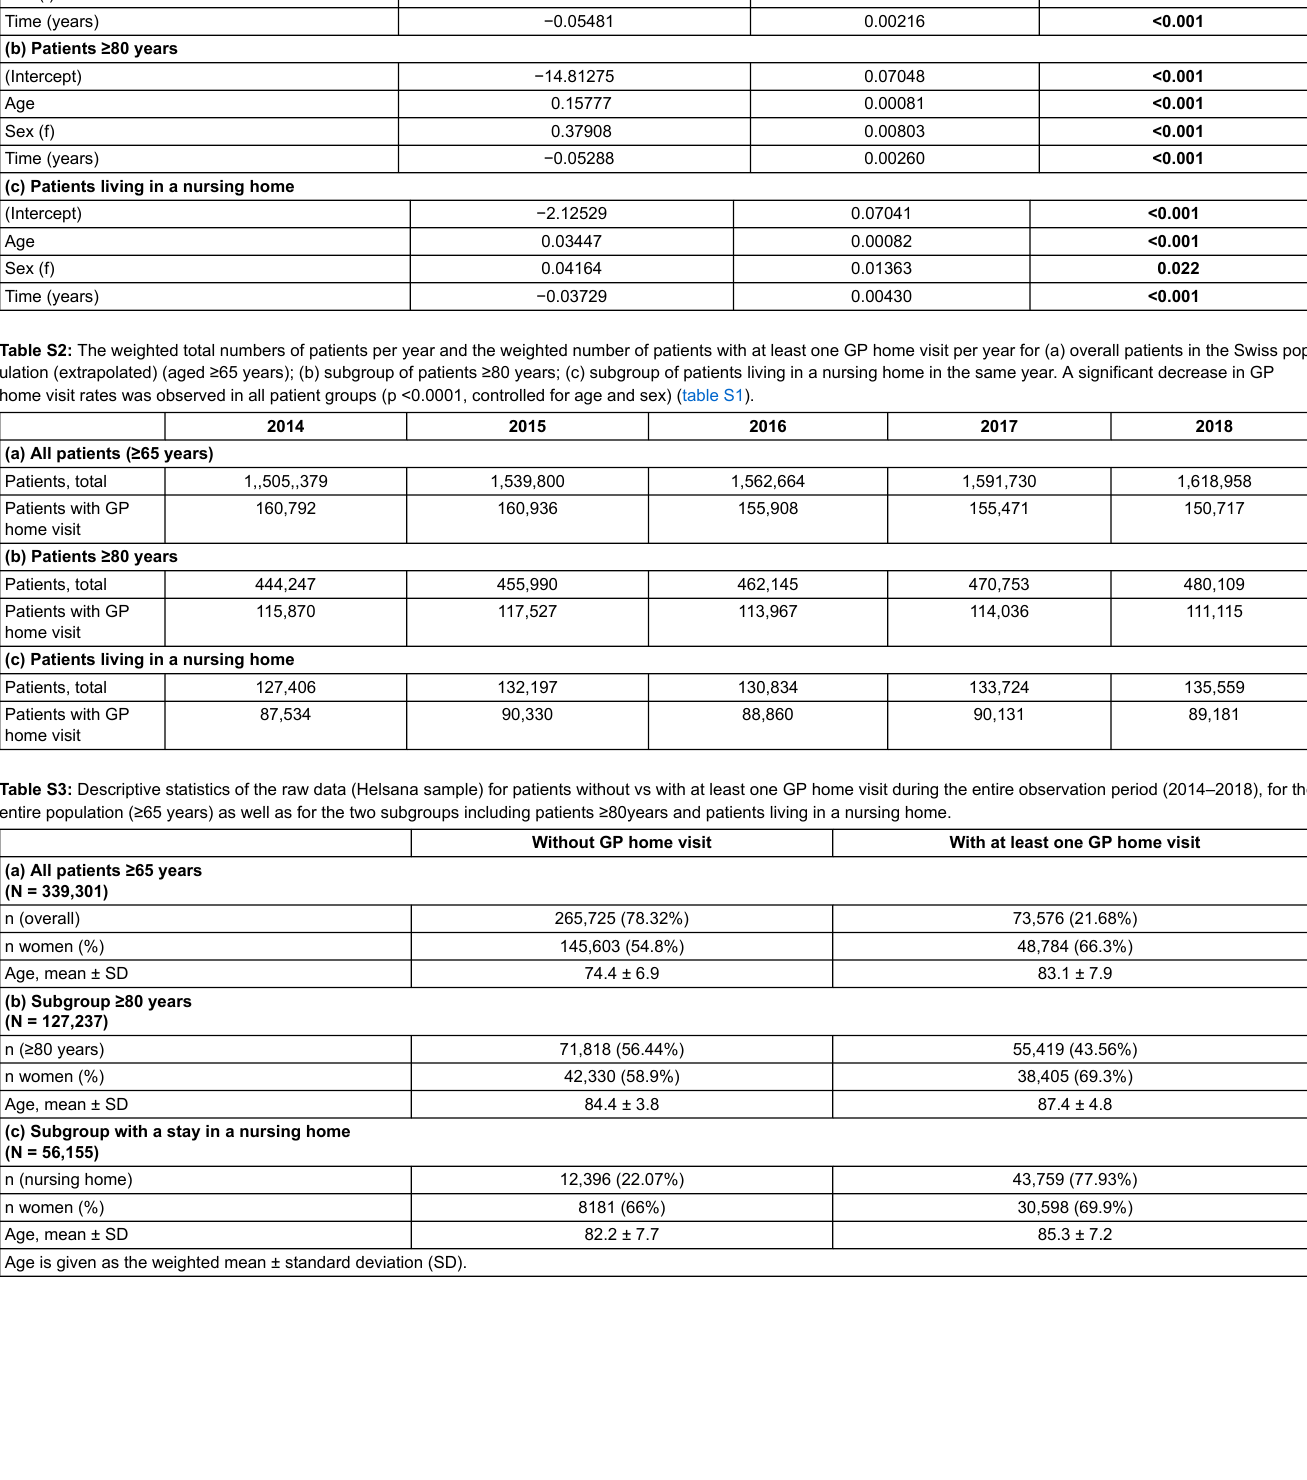
Table S1: Multiple logistic regression analyses testing for the effect of time for (a) all patients included in the study, (b) patients aged 80 or older, (c) patients living in a nursing home.